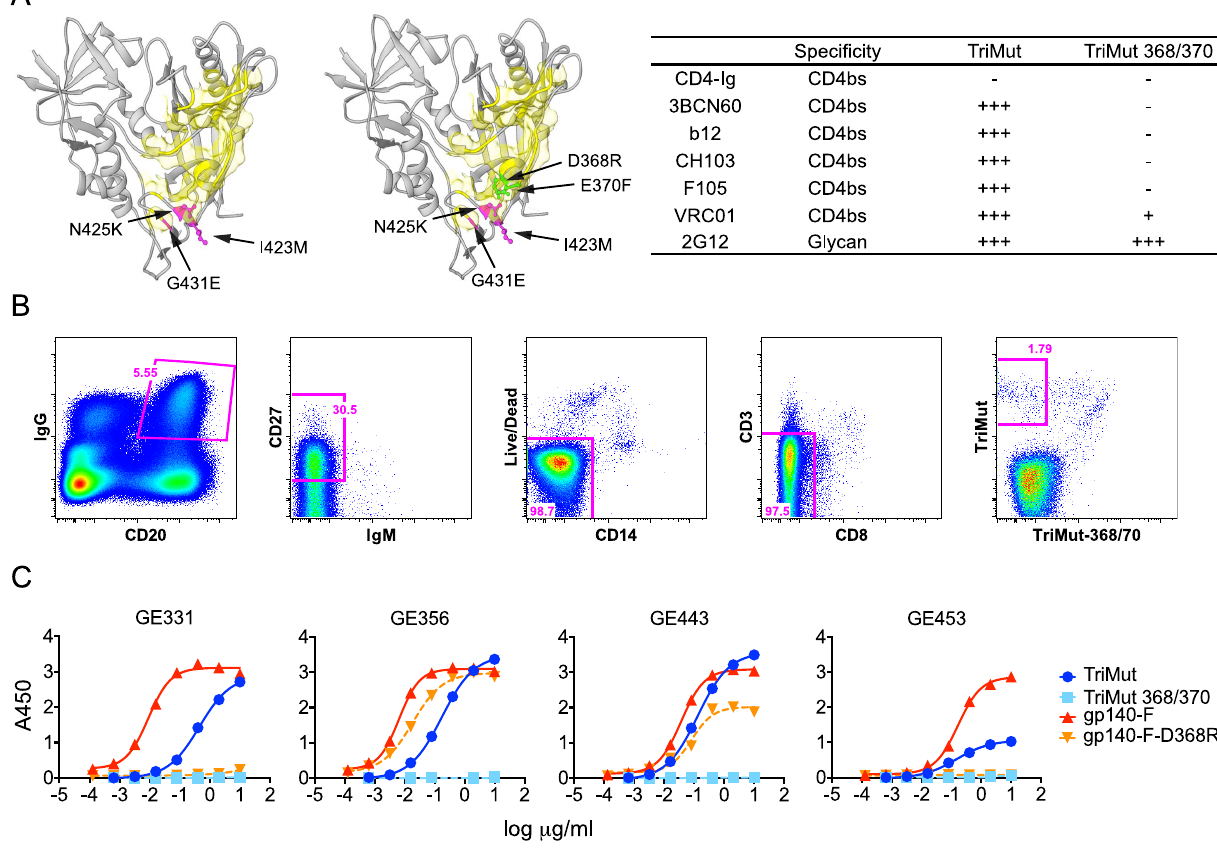
Figure 2. Isolation of HIV-1 gp120 CD4bs-specific vaccine-induced NHP memory B cells, NHP MAbs and their binding specificities. (A) Structural representation of the TriMut and TriMut368/370 probes that were used for sorting CD4bs-specific memory B cells. The key mutations for TriMut (I423M, N425K and G431E) are highlighted in hot pink. The additional TriMut368/370 mutations (D368R and E370F) used for negative selection are highlighted in green and the CD4 footprint is in yellow. The inserted table shows the binding profile of the probes with a panel of CD4bs antibodies and CD4-Ig. Relative binding to the probes was based on the OD450 values at the highest concentration of protein (10 m g/ml) and EC 50 values: OD450 $ 3.0 and EC 50 # 0.10= ++++ ; OD450 $ 3.0 and EC 50 . 0.10= +++ ; 2.0 # OD450 , 3.0= ++ ; 0.2 # OD450 , 2.0= + ; OD450 , 0.2= 2 . (B) Details describing the flow cytometric sorting of CD4bs-directed memory B cells using the TriMut and TriMut368/370 probes. Gating strategy for sorting IgG + and CD4bs-specific memory B cells; CD20 + , IgG + , CD27 + , CD3 2 , CD8 2 , CD14 2 , IgM 2 , TriMut and TriMut-368/370 were sorted at single cell density. (C) Four VH1.23-using MAbs (GE331, GE356, GE443 and GE453) were characterized for their capacity to bind trimeric gp140-F + / 2 D368R and TriMut + / 2 368/370 by ELISA. Titration curves are shown as Log 10 dilutions ( m g/ml). All antibodies were isolated from the post 2 immunization time